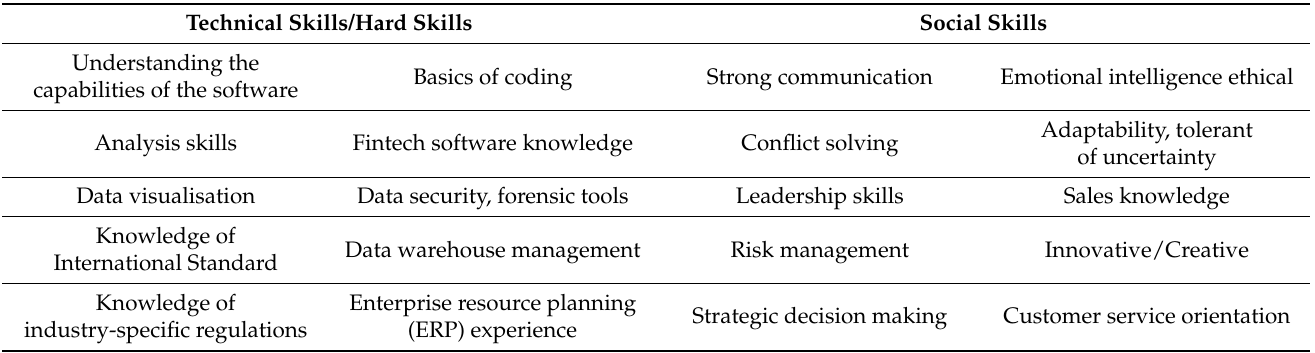
Table 2. Potential current and future skills